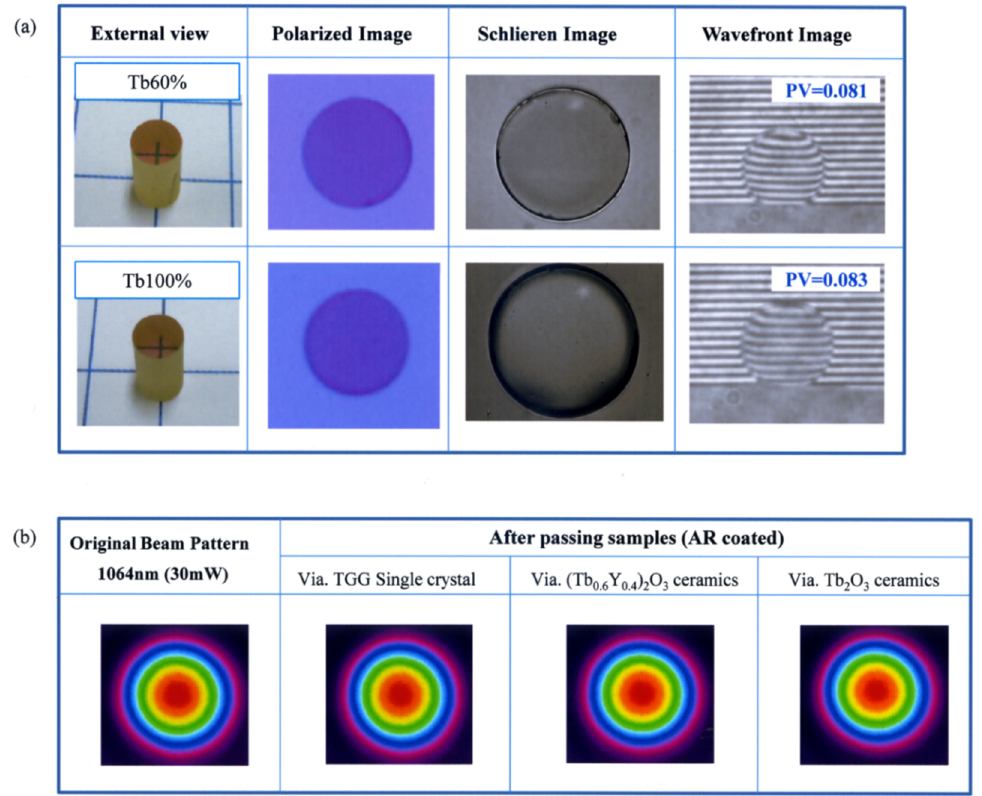
Figure 4. ( a ) External view, polarized image, Schlieren image, and wavefront image by interferometry of the (Tb 0.6 Y 0.4 ) 2 O 3 and Tb 2 O 3 ceramics. (The thickness of each sample was 11 mm.) ( b ) Original beam pattern and beam patterns after passing through the TGG single crystal and the produced (Tb 0.6 Y 0.4 ) 2 O 3 and Tb 2 O 3 ceramics.